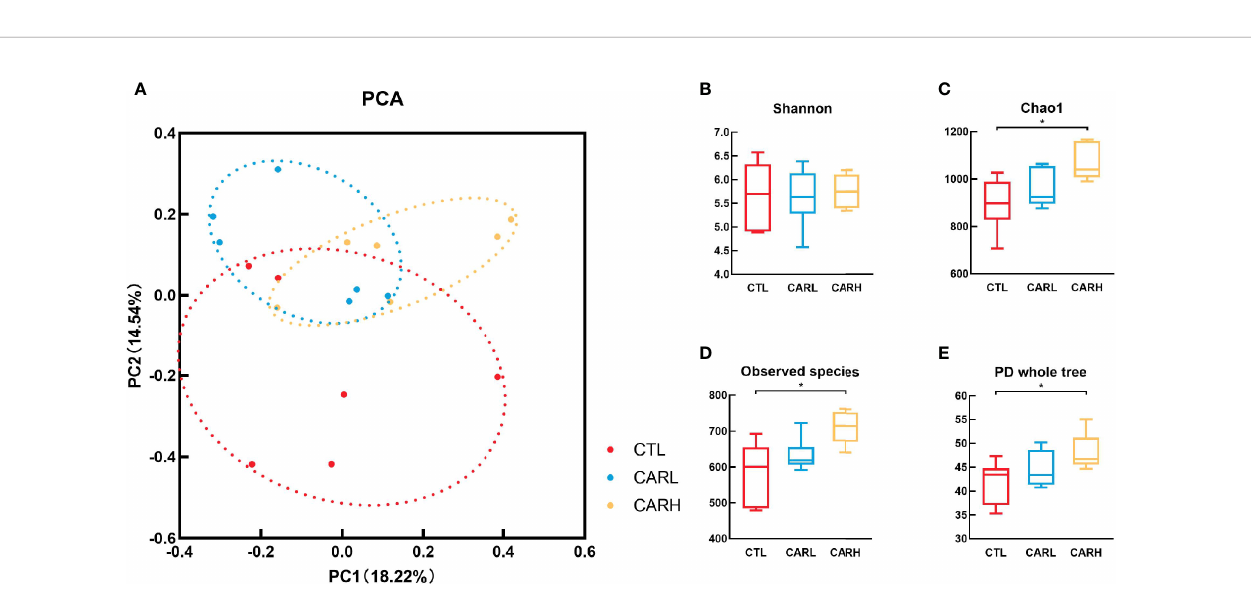
FIGURE 3 | Effects of b -carotene on microbiota diversity. Effect of b -carotene on genus-based (n=6) PCA (A) , Shannon index (B) , Chao 1 index (C) , Observed species index (D) and PD whole tree index (E) . CTL, a basal diet; CARL, a basal diet containing 30 mg/kg b -carotene; CARH, a basal diet containing 90 mg/kg b - carotene. Data were shown as means ± SD (n = 6). Anosim: R = 0.135, P = 0.049, * P < 0.05.